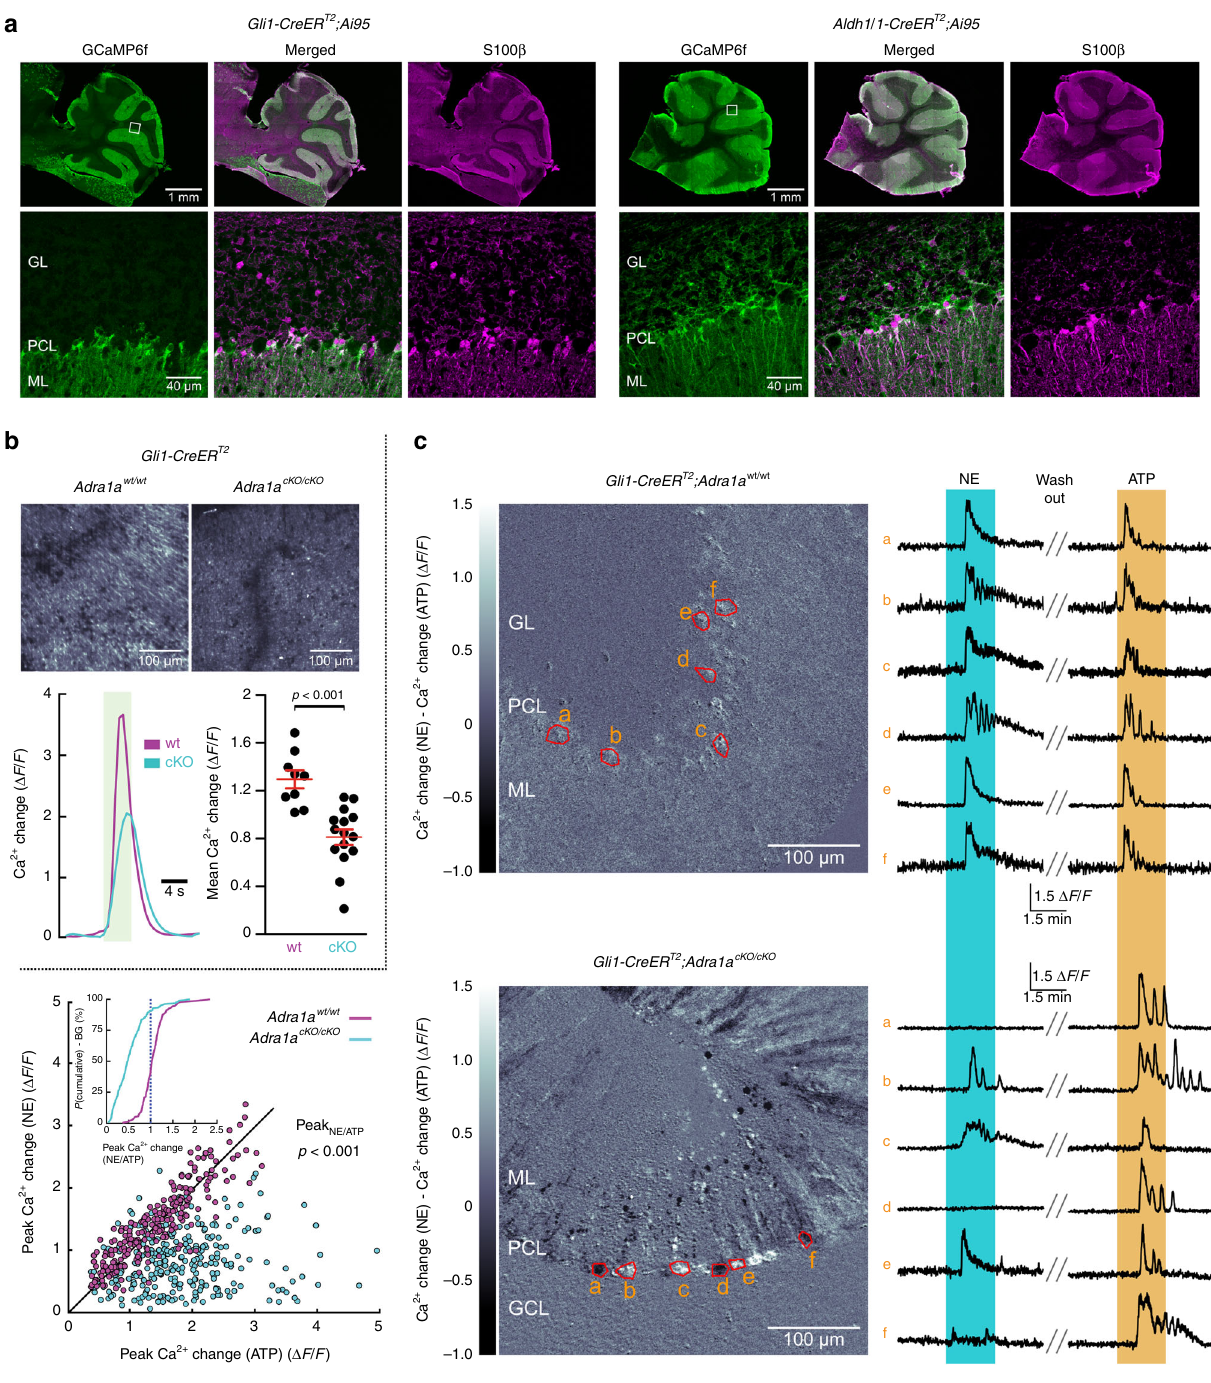
this hypothesis, we imaged V1 astrocytes in deep layer I, 60 – 80 μ m from the pial surface (Fig. 6a). Image frames were averaged during peak Ca 2 + activation to draw ROIs representing indivi- dual astrocytes and assess the activity pattern within the V1 astrocyte population (Fig. 6a, b). The same locomotion paradigm was applied as described for Fig. 1. Locomotion induced reliable astrocyte Ca 2 + elevations (Fig. 6b) and i.p. injection of ethanol (2 g/kg body weight) resulted in rapid, almost complete inhibition of V1 astrocyte activation (Fig. 6b). Ethanol inhibition of V1 astrocyte activation, as observed for BG in the cerebellum, was similarly dose-dependent and lasted for at least 30 min (Fig. 6c). Ethanol reduced the mean Ca 2 + elevation (Fig. 6e). V1